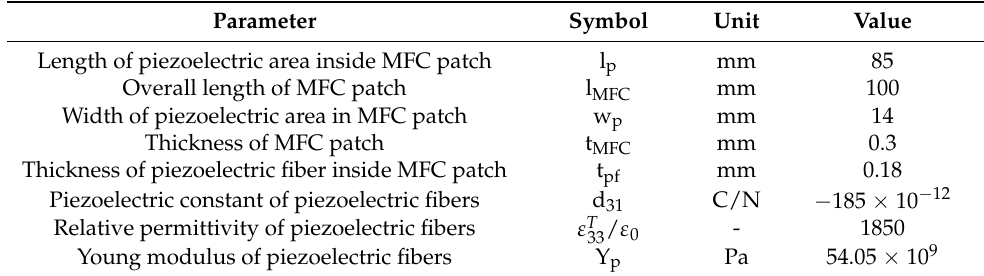
Table 2. Geometric and material properties of MFC patches [24–26].